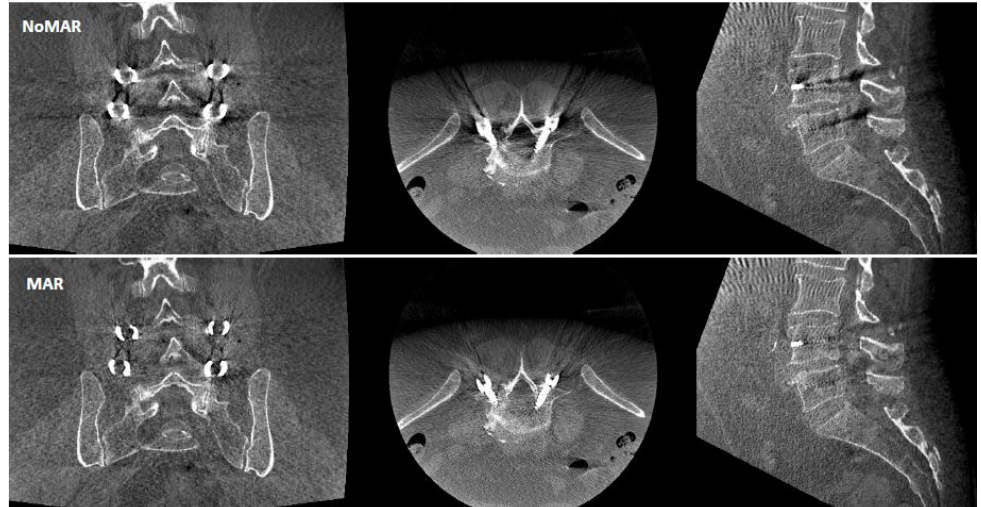
Figure 1. Image quality for one patient using CBCT reconstruction without metal artifact reduction algorithm (NoMAR) and with metal artifact reduction algorithm (MAR) based on interpolation of projection data surrounding the metal shadow around the pedicle screws.